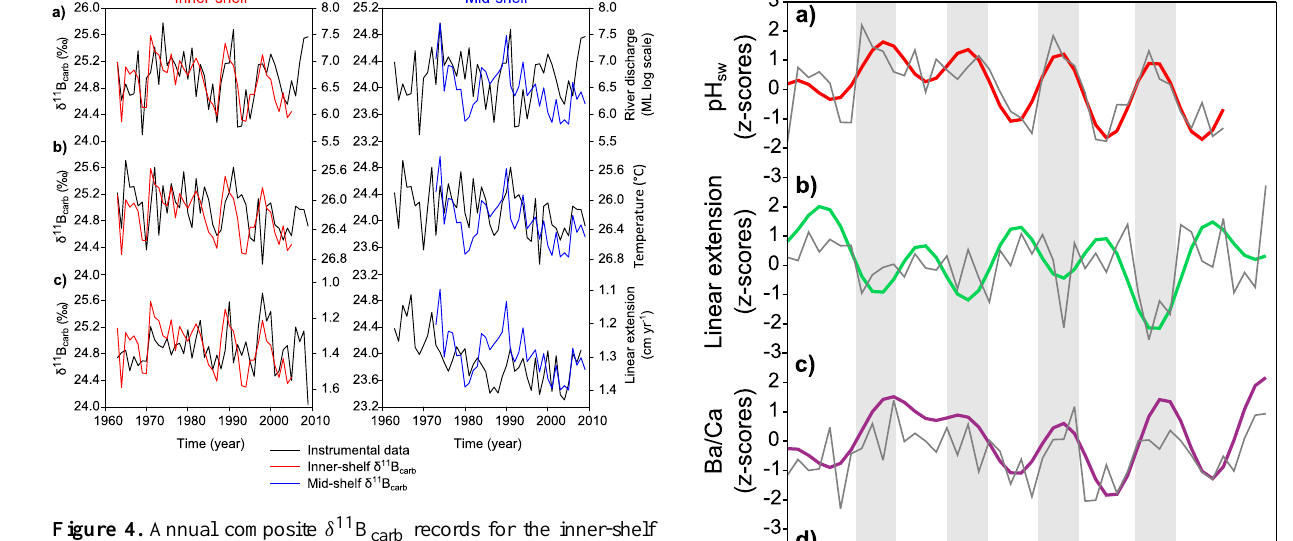
Figure 4. Annual composite δ 11 B carb records for the inner-shelf corals and mid-shelf corals compared to annual discharge from the Burdekin River (a) , SST from HadISST1 (b) , and coral linear ex- tension rates from D’Olivo et al. (2013) for the corresponding inner- shelf or mid-shelf regions (c) . Note that the temperature and linear extension axis has been reversed to facilitate comparisons.